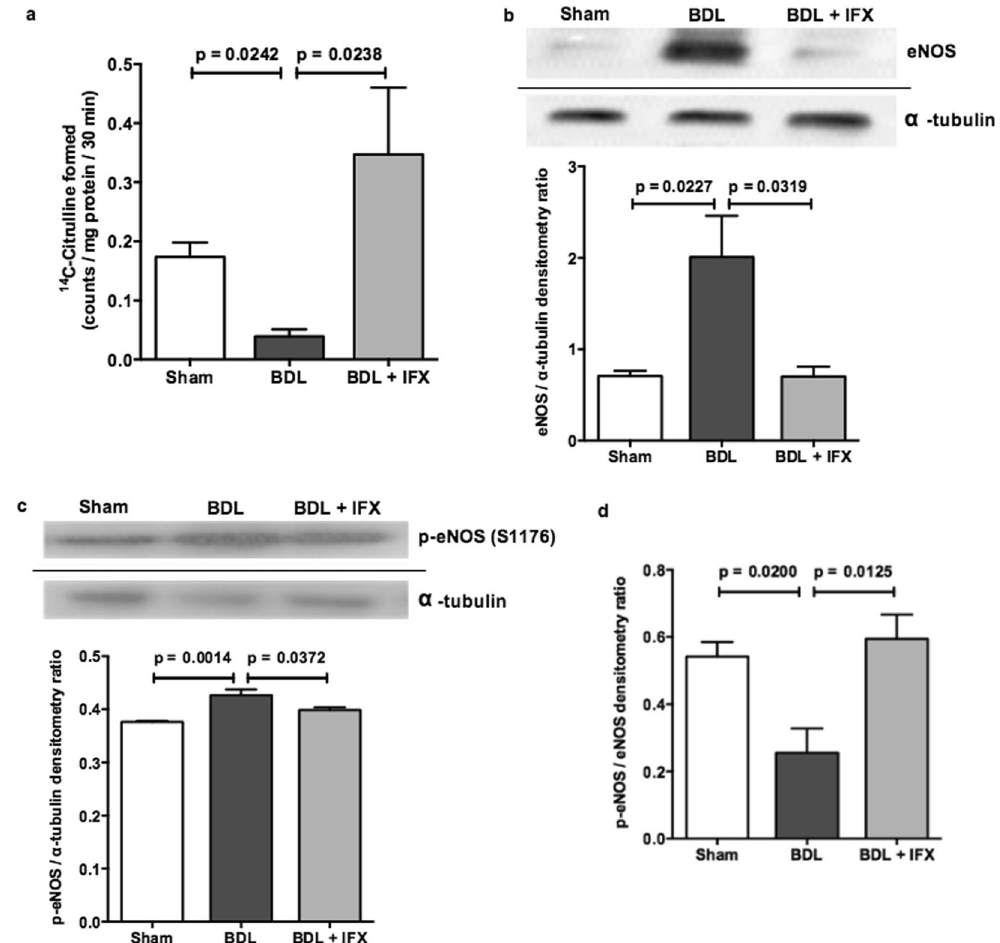
Figure 3. eNOS expression and activity in rat liver. ( a ) eNOS activity is decreased in BDL rat liver compared to sham, and is increased by treating BDL rats with IFX. (Sham n = 7; BDL n = 4; BDL + IFX n = 3). ( b ) Western blot analysis shows that eNOS protein expression is increased in BDL rat liver compared to sham, and is reduced by treating BDL rats with IFX. Following detection of eNOS, western blots were stripped and reprobed for detection of α -tubulin. (Sham n = 4; BDL n = 4; BDL + IFX n = 3). ( c )Western blot analysis shows that the phosphorylated eNOS (p-eNOS, ser-1177) active form is increased in BDL rat liver compared to sham, and is reduced by treating BDL rats with IFX. Following detection of p-eNOS, western blots were stripped and reprobed for detection of α -tubulin. (Sham n = 4; BDL n = 4; BDL + IFX n = 3). ( d )The ratio of p-eNOS to eNOS densitometry (from panels b and c) is reduced in BDL rat liver compared to sham, and is increased with IFX treatment. (Sham n = 4; BDL n = 4; BDL + IFX n = 3).